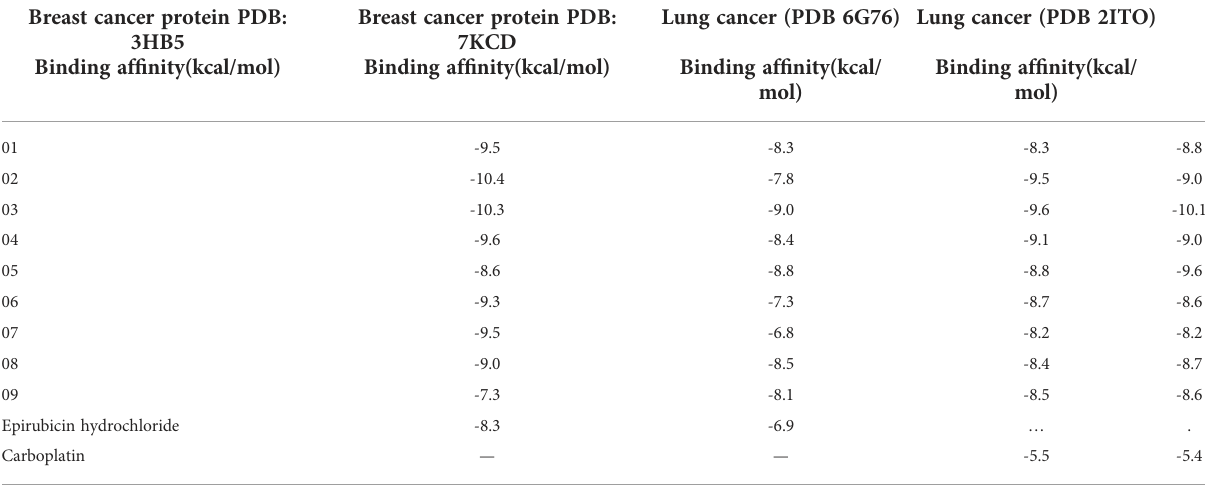
TABLE 3 Binding af fi nity against breast and lung cancer protein. Drug molecules number Breast cancer protein PDB: